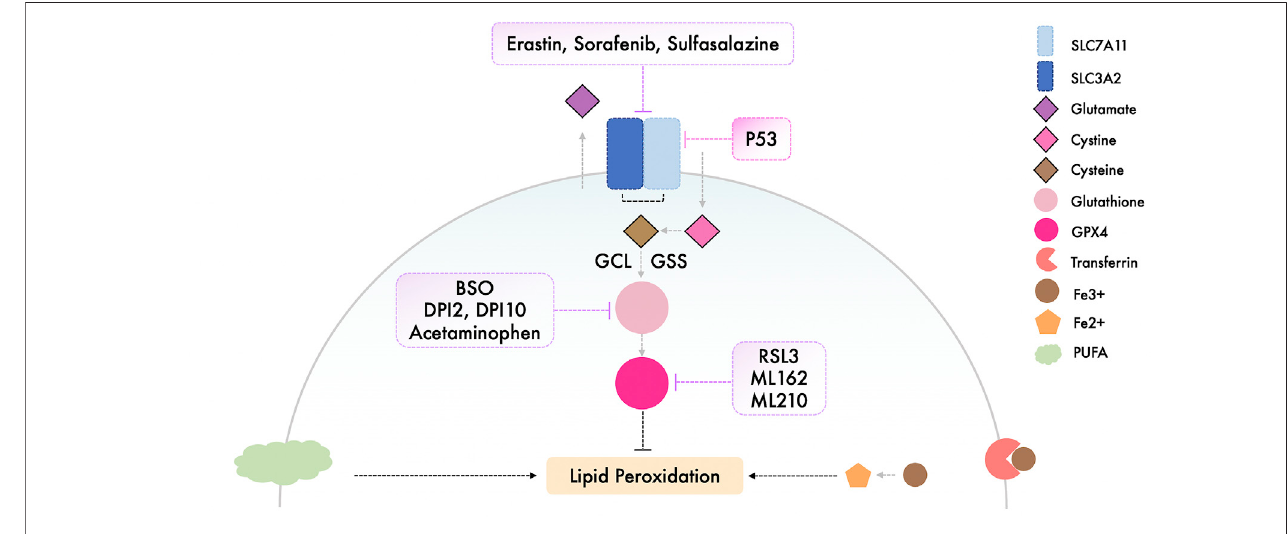
FIGURE 2 | Illustration of the available ferroptosis inducers.